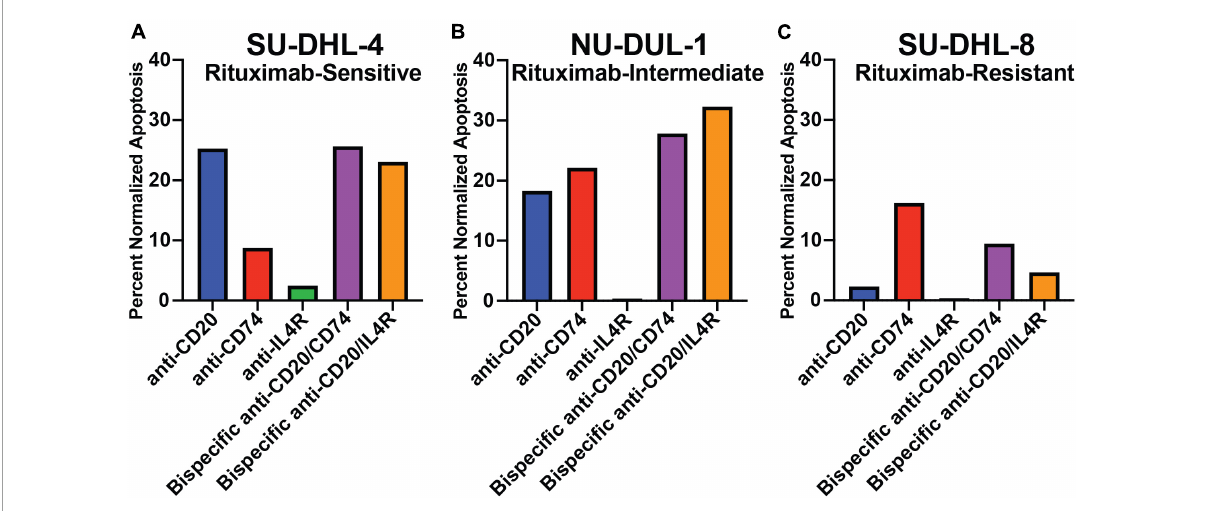
FIGURE3 Apoptotic response to crosslinking antibodies within varying rituximab-resistant lymphoma cell lines, measured by annexin V staining. (A) Bar graph of the percent of total apoptosis within rituximab-sensitive, high CD20 expressing, SU-DHL-4 cells after 8 h of exposure to antibodies and crosslinking antibodies. (B) Bar graph of the percent of total apoptosis within rituximab-intermediate, intermediate CD20 expressing, NU-DUL-1 cells after 8 h of exposure to antibodies and crosslinking antibodies. (C) Bar graph of the percent of total apoptosis within rituximab-resistant, low CD20 expressing, SU-DHL-8 cells after 8 h of exposure to antibodies and crosslinking antibodies. All bar graphs normalized to respective cell line crosslinking antibody